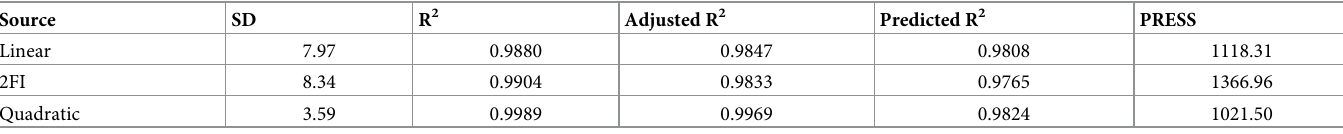
Table 3. Model fit statistics for the particle size of ALS-MP